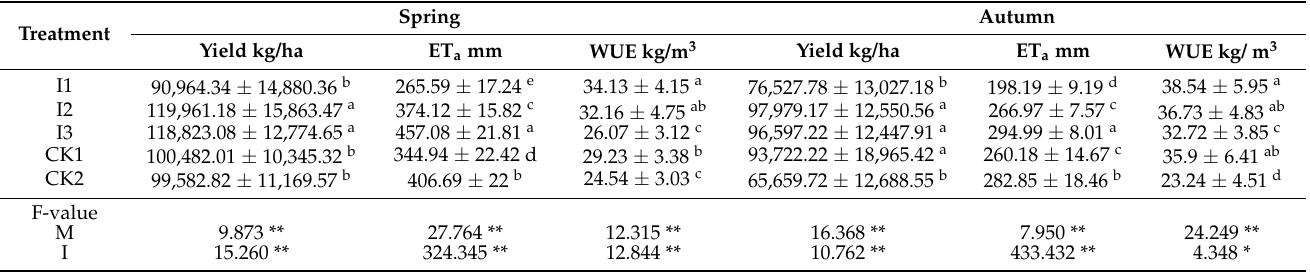
Table 5. Effects of different treatments on yield and water use efficiency of spring and autumn